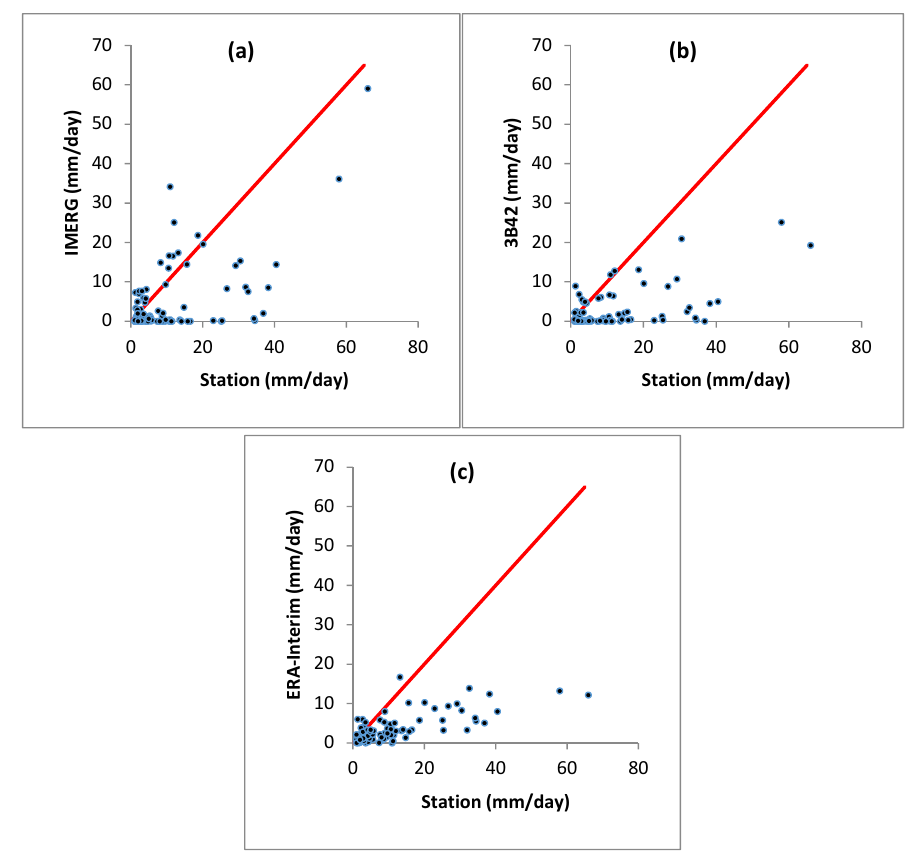
Figure 4. Daily precipitation events scatter plots for Guilan of IMERG ( a ); 3B42 ( b ) and ERA-Interim ( c ) against gauge data (mid-March 2014 to February 2015)